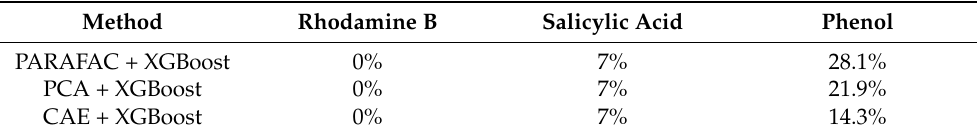
Table 4. Misreporting rate of organic pollutants to drinking